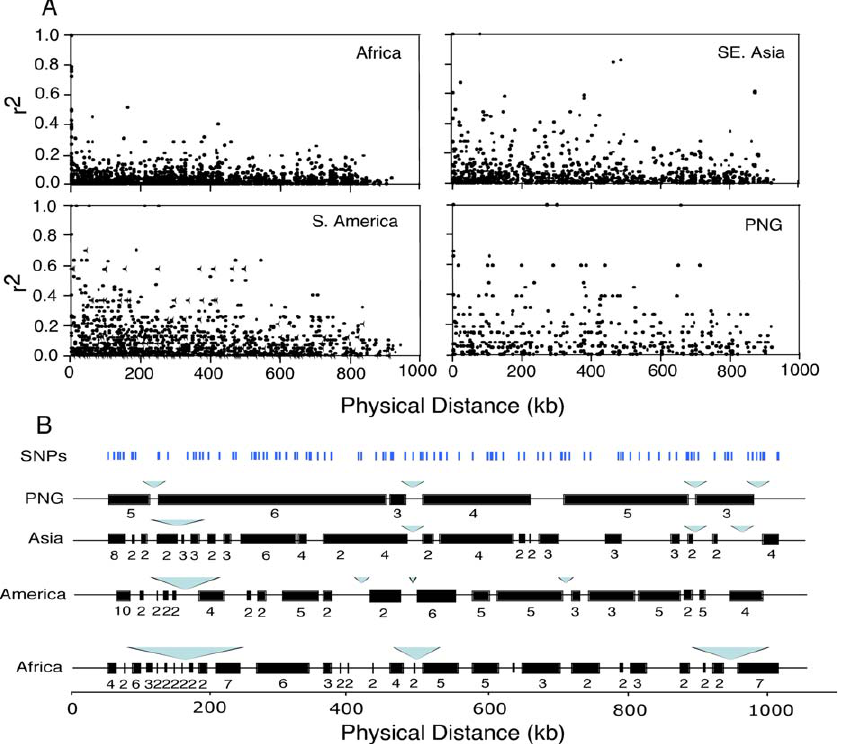
Figure 3. LD and Haplotype Blocks across Chromosome 3 of P. falciparum (A) LD decays with increasing distances between variable sites along Chromosome 3 in populations from Africa, SE Asia, S America, and PNG. The LD index r 2 (square of correlation coefficient) were calculated considering all pair-wise values for SNPs with minor allele frequency . 5%. Parasite isolates K1, Camp, T2/C6, 105/7, 3D7, HB3, Haiti, JAV, ECP, 569, and 1905 are excluded from the LD analyses because these parasites were placed in clusters different from locations they were isolated from or have different genetic backgrounds. (B) Haplotype blocks defined as regions where all pairs of sites have D 9 (cid:3) 0.8. Values below each block are the number of htSNPs required to capture all haplotype variants when haplotype blocks are characterized by complete association among variants (r 2 ¼ 1). Bars on the top are locations of assayed SNPs. Triangles denote a site in the middle of a recombination hotspot, and the width of the triangles represents the region hotspot spans. DOI: 10.1371/journal.pbio.0030335.g003